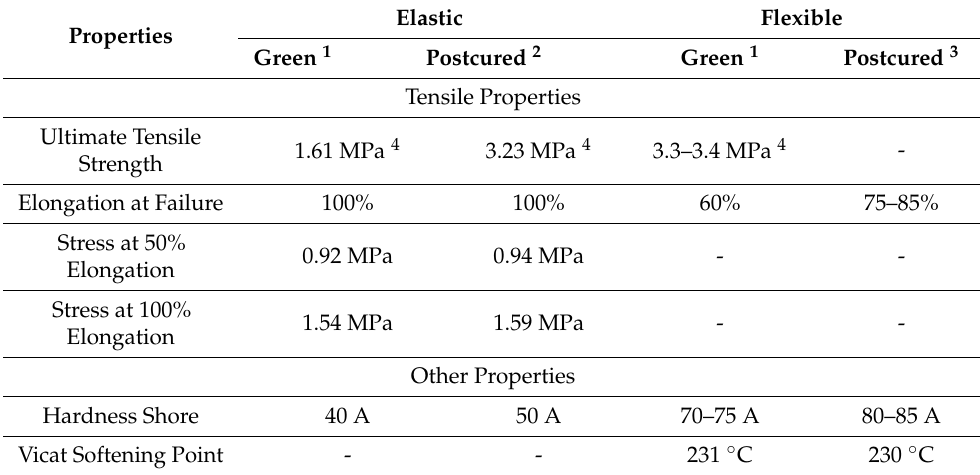
Table 4. Mechanical properties of elastic and flexible resins [35,36].